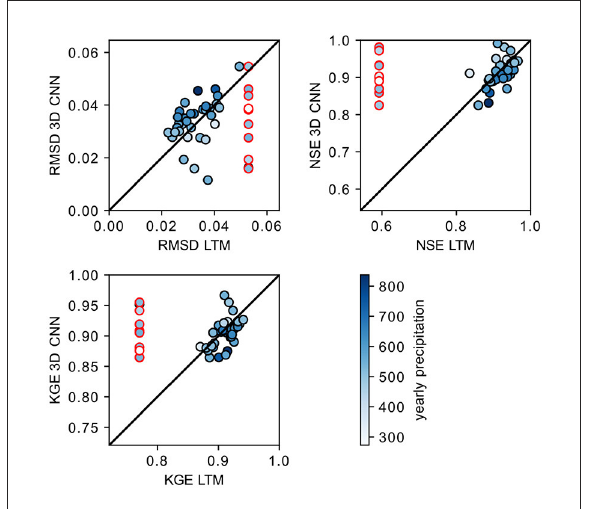
FIGURE10 The mean root mean square error (RMSD, first row of plots), Nash-Sutcliffe Efficiency (NSE, middle row of plots), and Klige-Gupta Efficiency (KGE, lower row of plots) as a function of the total precipitation (left column of plots) or the mean hourly temperature (right column of plots) computed for each water year. The color identifies water years used in training, validation, and testing. The water year 2002, used for all the results reported here is marked blue. Black lines represent the trends of a linear